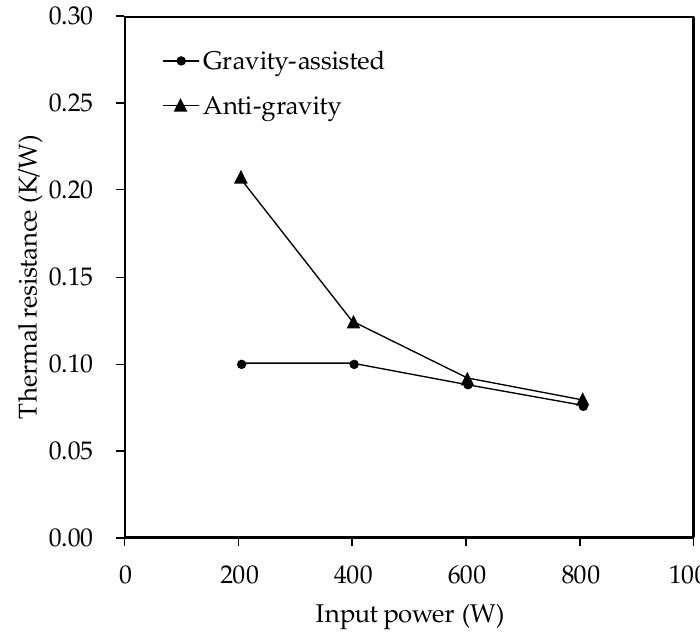
Figure 12. Thermal Resistance (K/W) vs. input power (W) of evaporator.